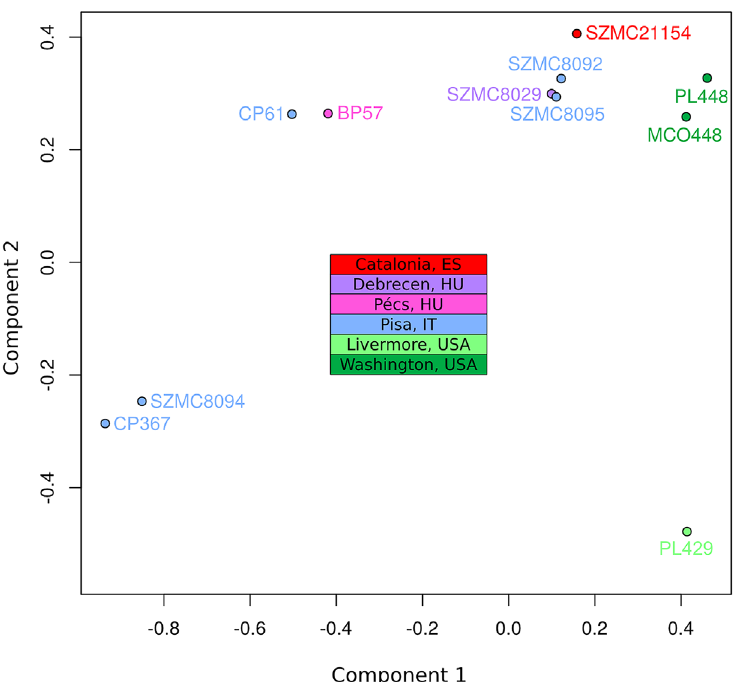
Fig 4. Multiple correspondence analysis (MCA) of genome diversity, based on 618,120 SNPs. The countries of isolation are indicated for all strains. SNPs from four genomic libraries of PL429 (pe300, pe400ov, pe600 and mp5000) were analysed separately, but all four libraries clustered together. For simplicity, the plot shows only PL429 results for one library